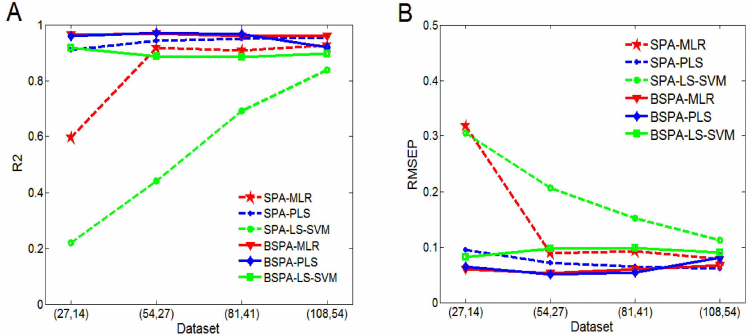
Figure 4. Experimental comparison of small sample sizes: ( A ) correlation coefficient and ( B )